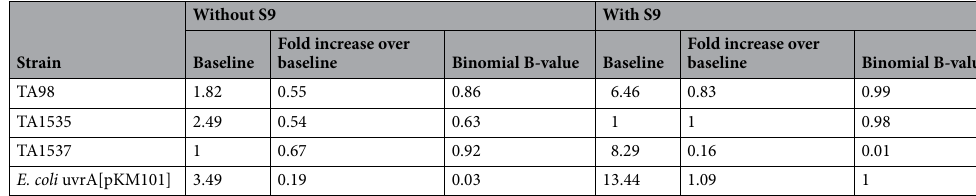
Table 4. AMES assay results.